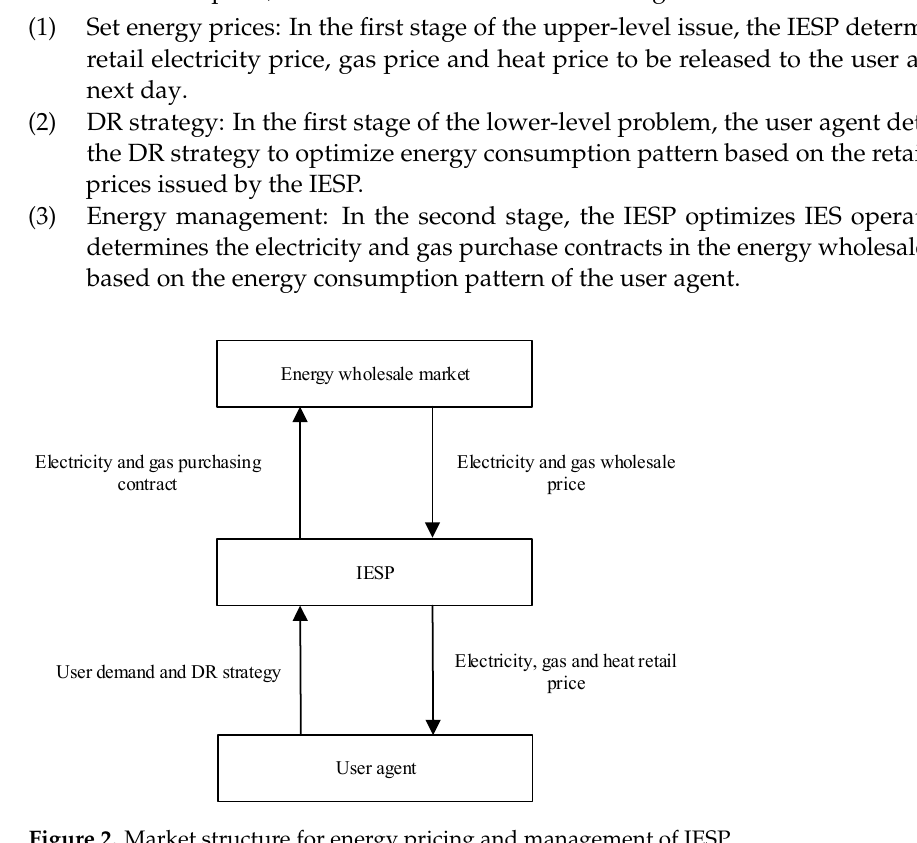
Figure 2. Market structure for energy pricing and management of IESP.